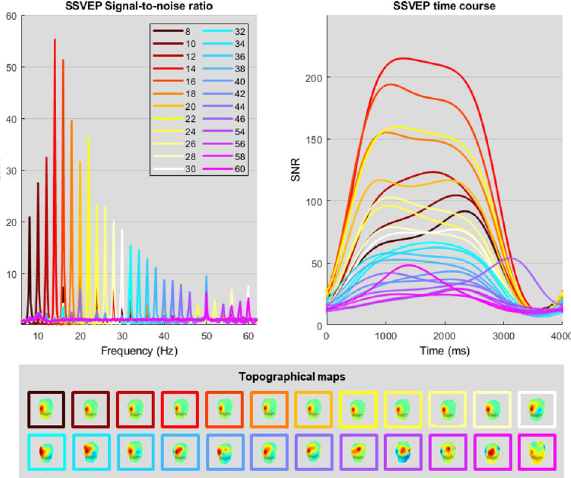
Figure 2. Experiment 1: rhythmic entrainment source separation (RESS) 24 analyses of SSVEP responses to RVS ranging from 8 to 60 Hz (step increase of 2 Hz, with the exclusion of line noise neighbouring frequencies 48, 50 and 52 Hz). Top left: power spectrum of the SSVEP signal-to-noise ratio (SNR). Top right: SSVEP response over the course of the 3 s RVS presentation. Bottom: topographical distribution of SSVEP responses to RVS.